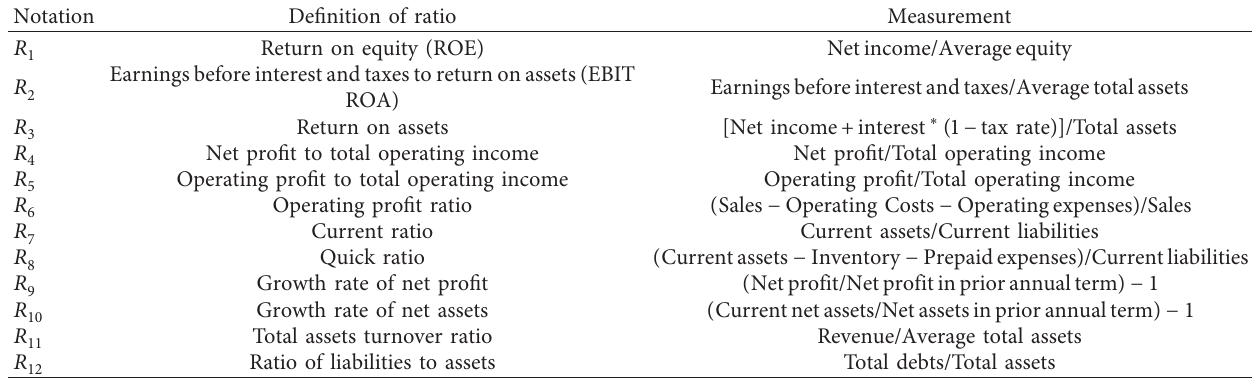
Table 1: Definition and measurement of financial